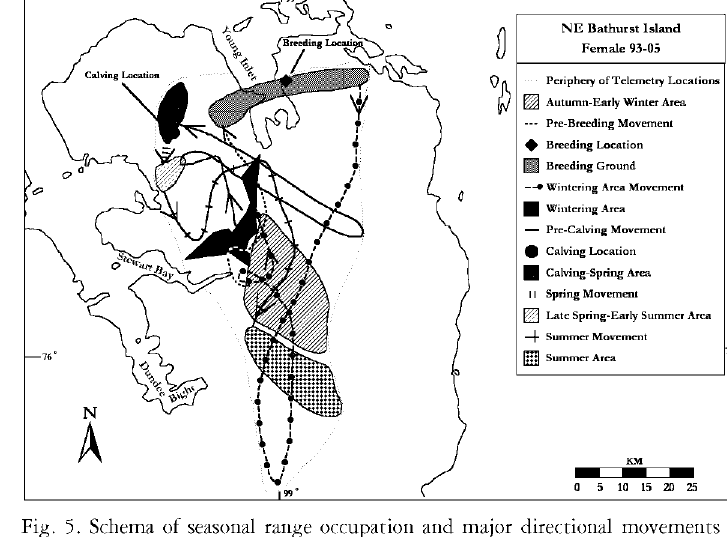
Fig. 5. Schema of seasonal range occupation and major directional movements of female Peary caribou 93-05 during the annual-cycle of the study period, Bathurst Island, Canadian High Arctic, 1 August 1993 to 31 July 1994: extrapolated from satellite location-data points. more than half of the annual-cycle on her respective Wintering Area (mean±SD = 179.3±18.2 days): duration, 158-200 days (Figs. 2-5). Two of the females (93-03, 93-04) occupied a Pre-Calving Area for 14 and 13 days, respectively, before making their Pre-Calving Movement. The Pre-Calving Movement varied from 4 to 14 days (mean±SD=10.3±4.8 days) among the four females. Three of the females (93-02,